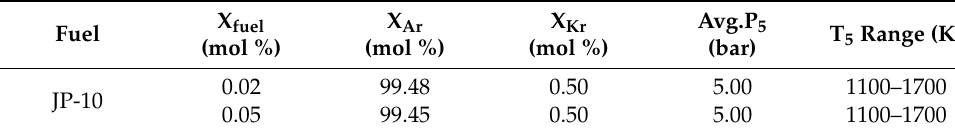
Table 3. Pyrolysis experimental conditions in this work.